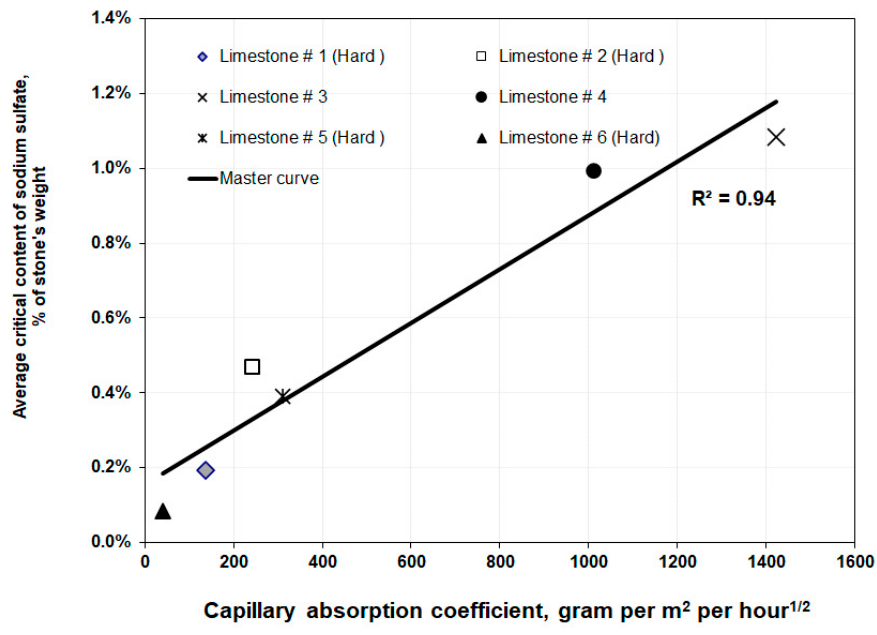
Figure 4. Relationship between the critical content of sodium sulfate and capillary water absorption of limestones.